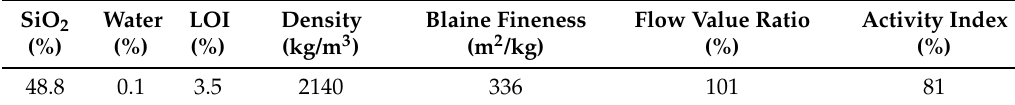
Table 5. Properties of fly ash.